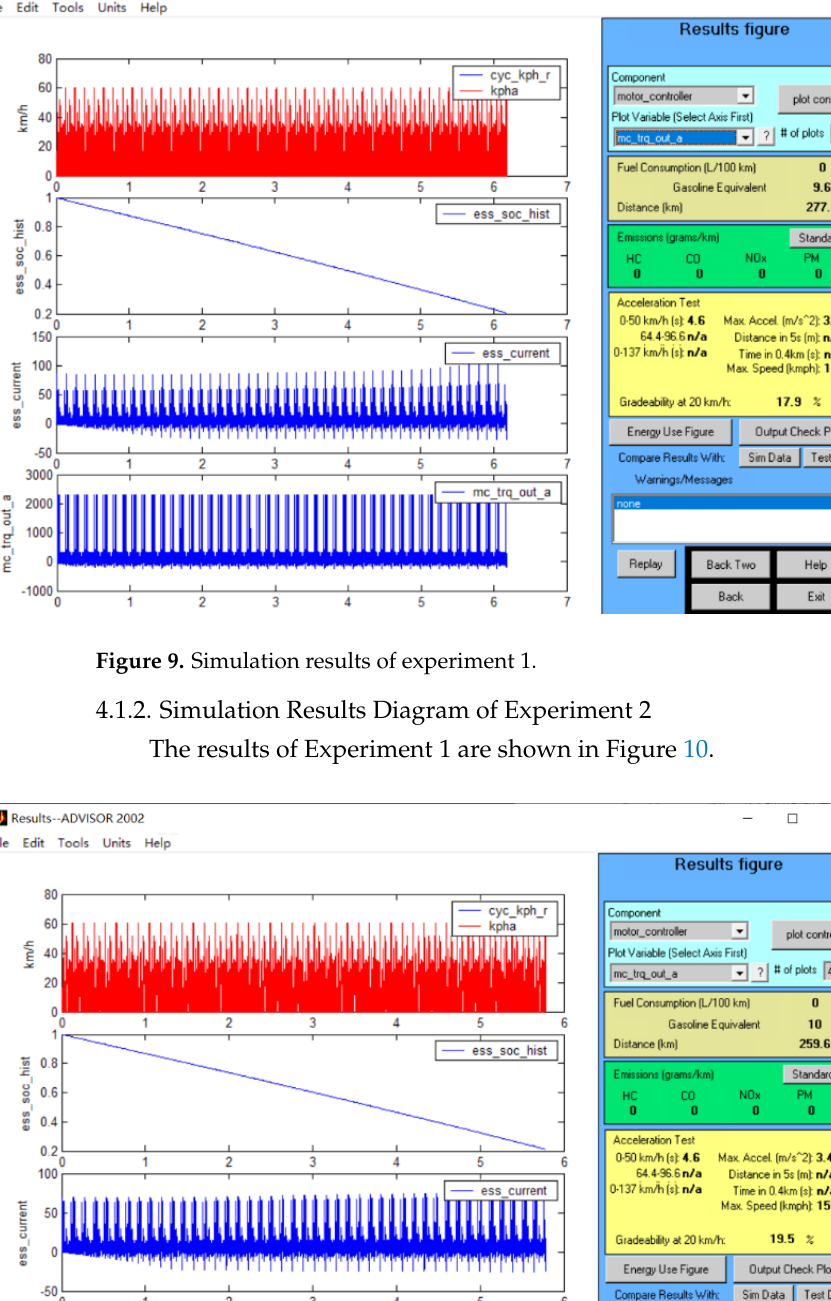
The results of Experiment 1 are shown in Figure